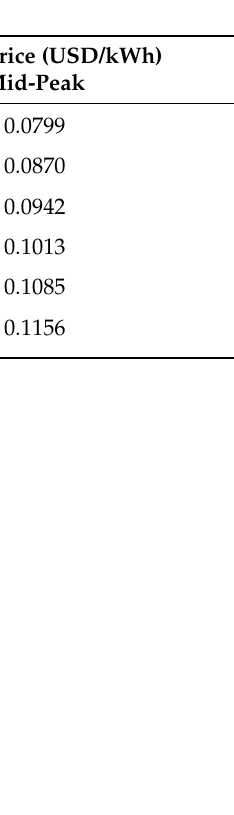
Table 3. Energy price with varying price factor.